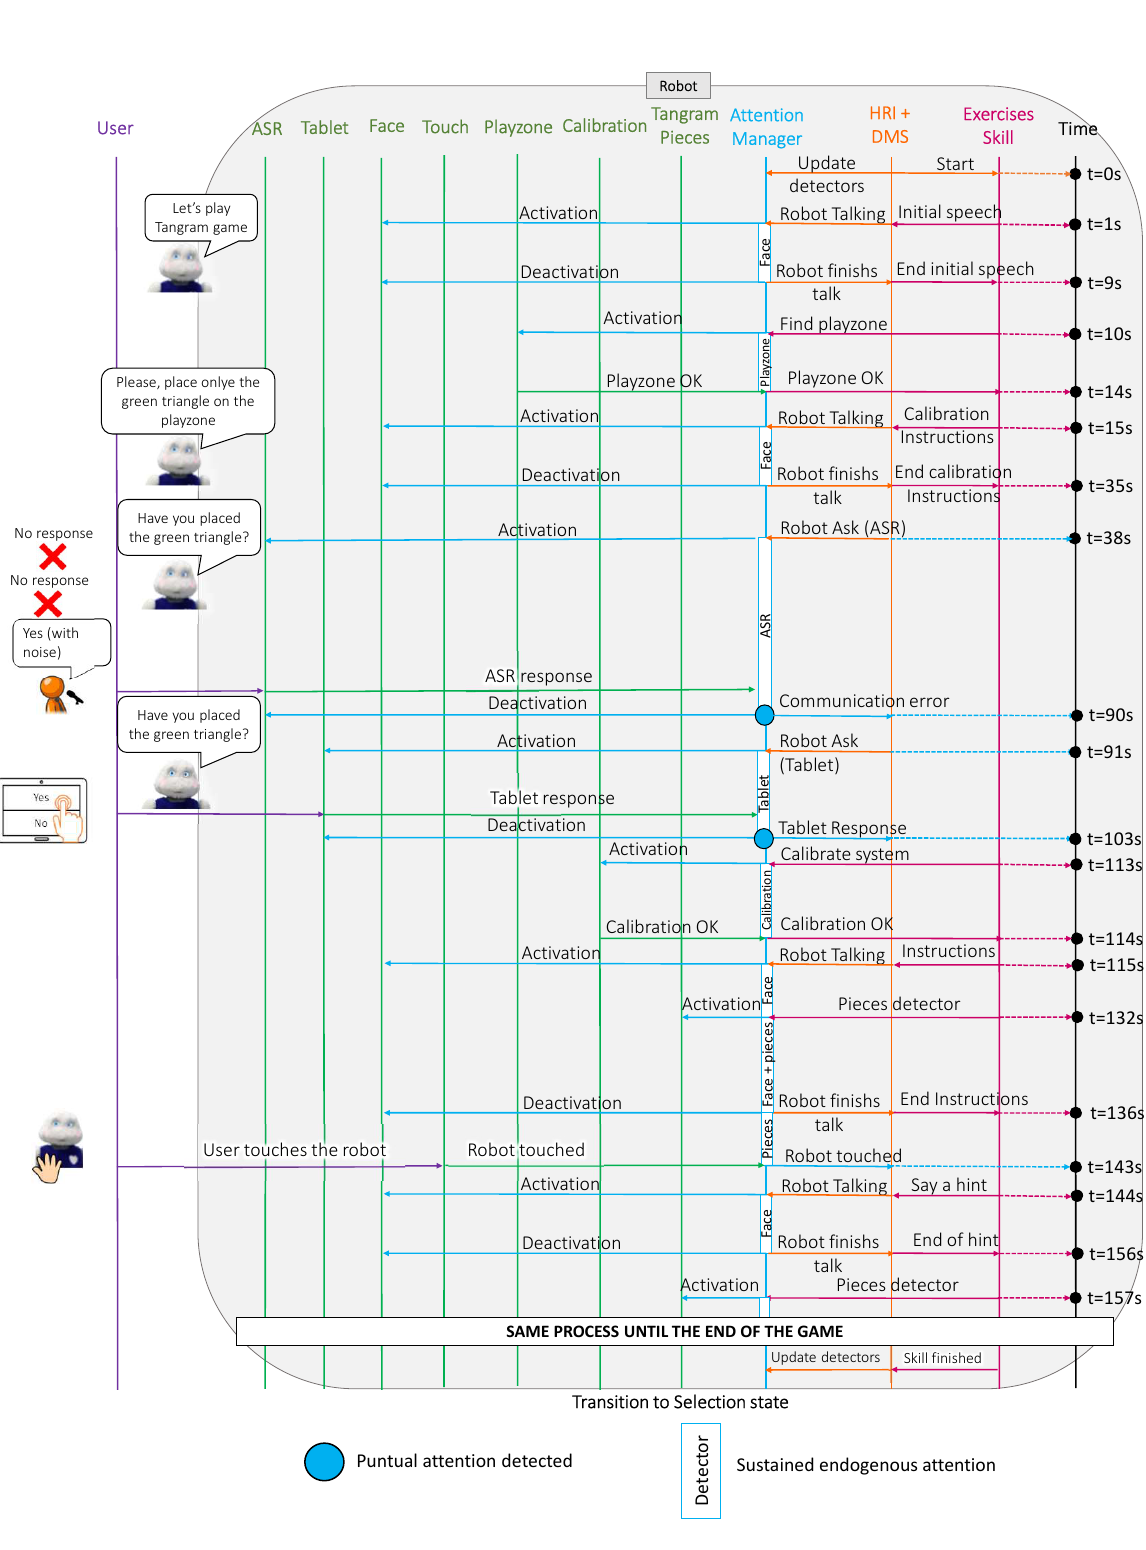
Figure 10. A sequence diagram of the connections between the different software blocks in the Mini during the execution of the tangram